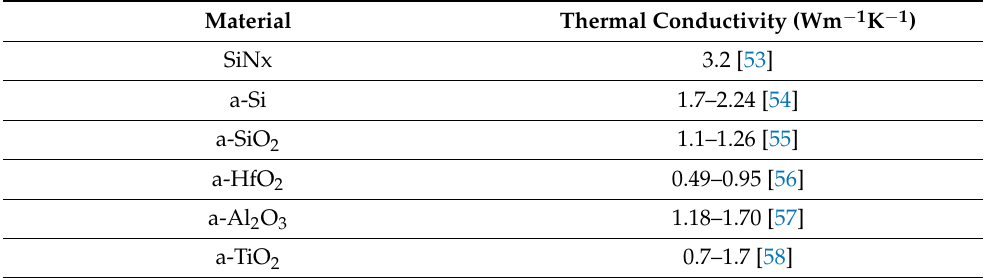
Table 1. Thermal conductivity of widely used materials in microelectronics